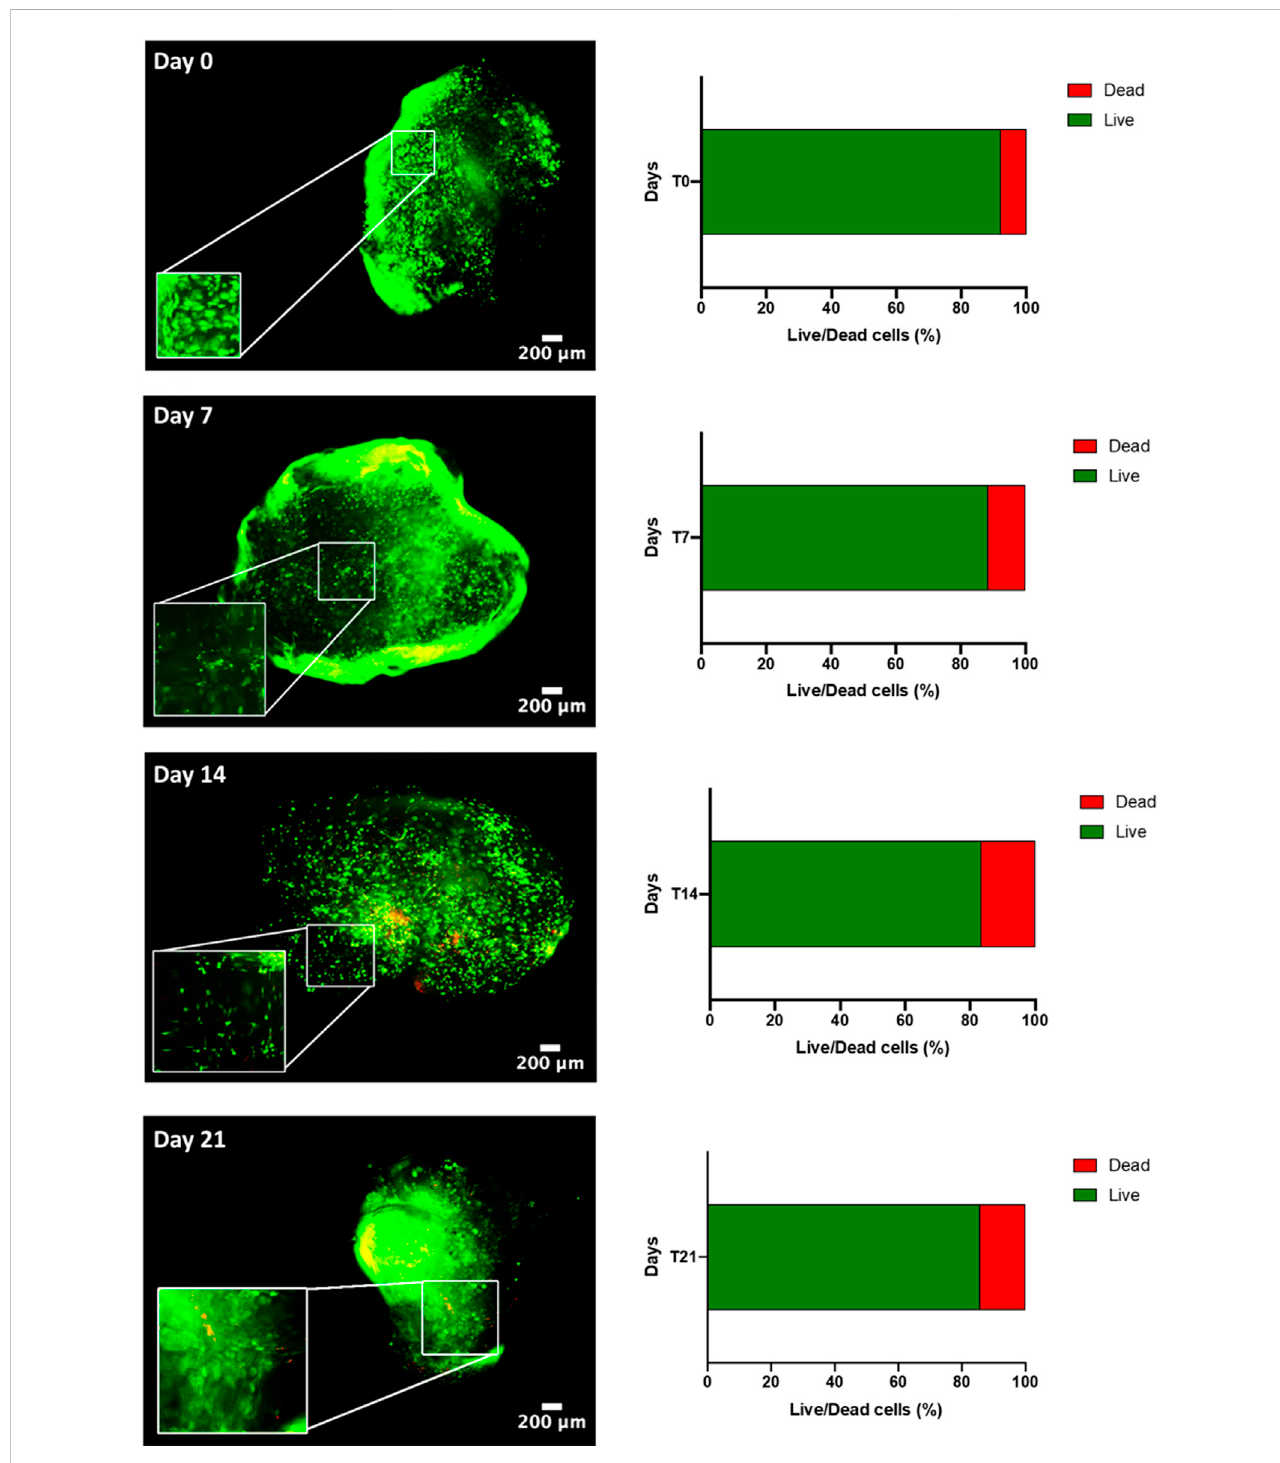
FIGURE 2 Live & Dead of h BM-MSC- h SkM-PBMC viability in a 3D fi brin scaffold cultured in perfusion system. Live cells are in green while dead cells in red. Images were captured at day 0, 7, 14 and 21 of culture, at ×4 magni fi cation, scale bar: 200 μ m, while zoomed areas are at 200%. Histograms report viability quanti fi